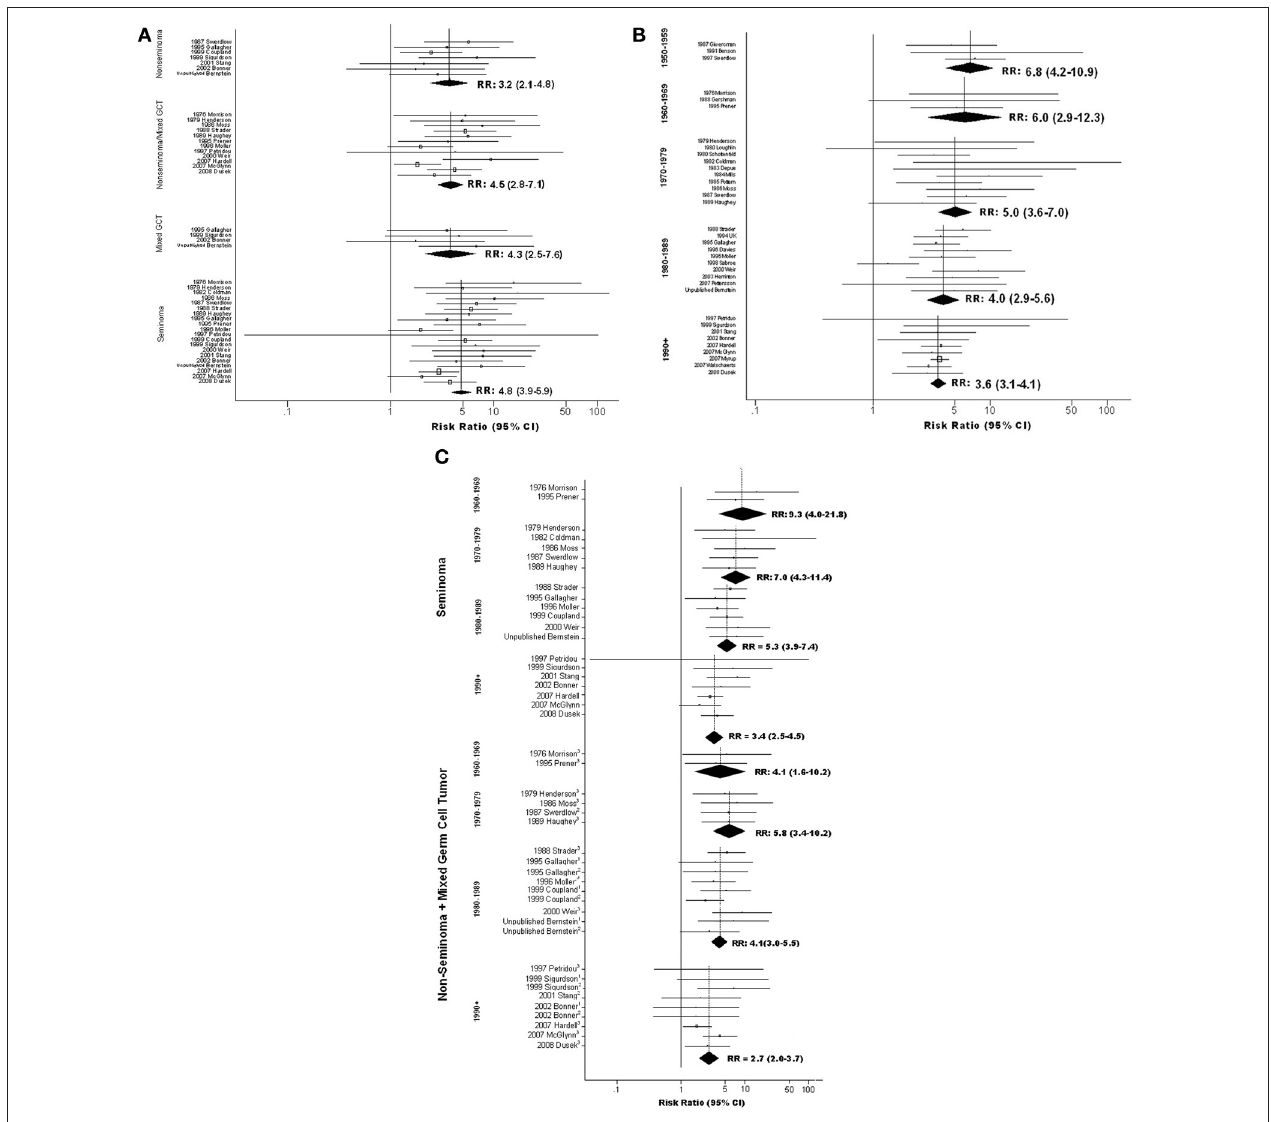
FIGURE 3 | Forest plots of relative risk estimates relating cryptorchidism to risk of TGCT, stratified by features of TGCT; (A) By histologic type of tumor; (B) By year of TGCT diagnosis